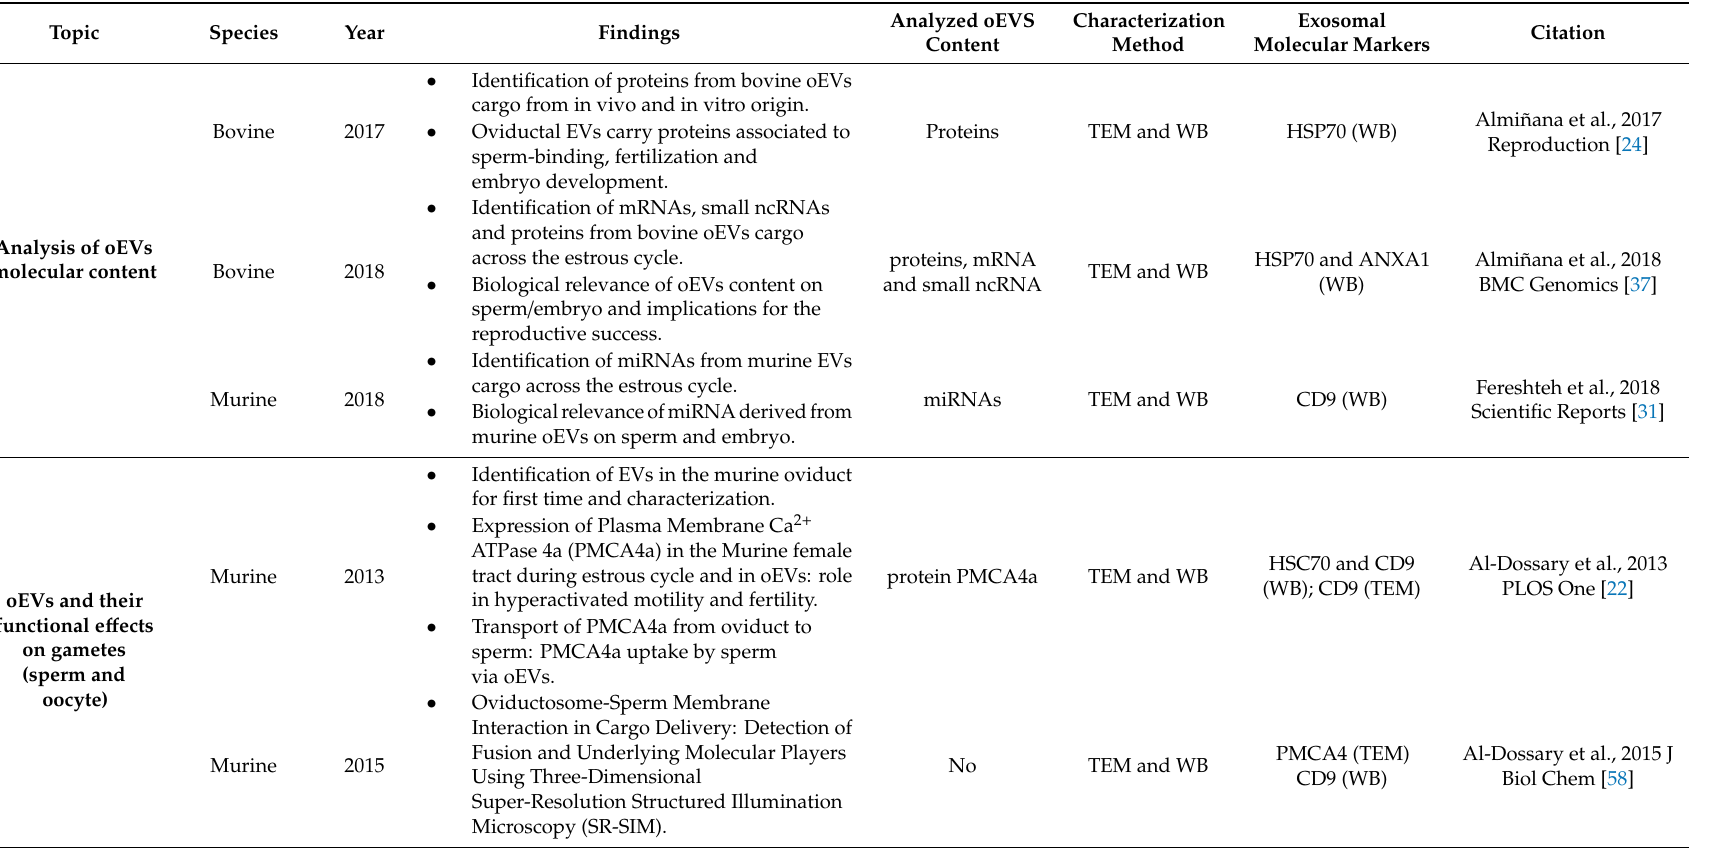
Table 1. Summary of published studies related to oviductal extracellular vesicles